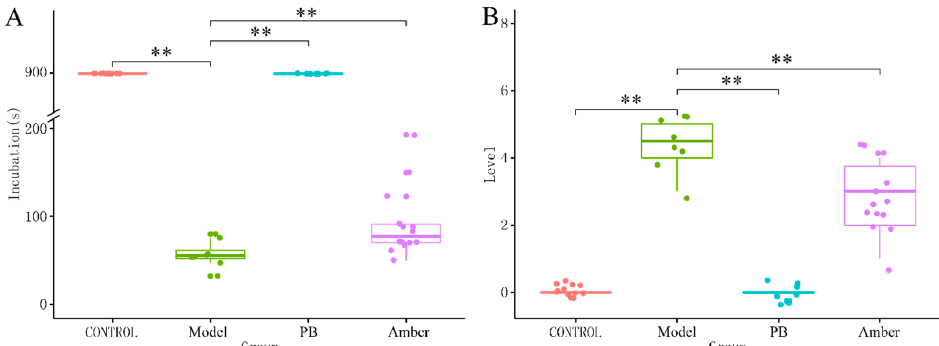
Figure 1. The effect of amber on behavior in the seizure model induced by pentylenetetrazole. ( A ) The incubation time of each group. Control group and PB group had no incubation time, and used 900 s for analysis. Under the intervention of amber, the incubation period was significantly reduced compared to the model group. ** p < 0.01 for extremely significant difference.